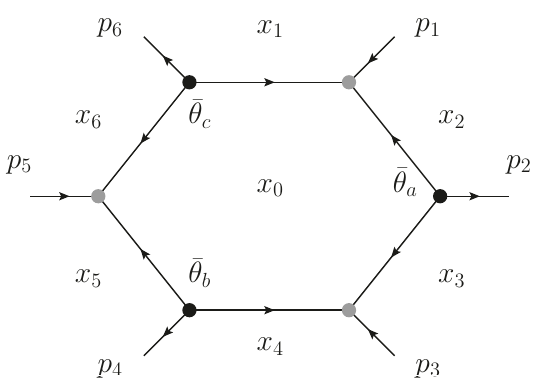
Figure 11 . One-loop supergraph for the amplitude